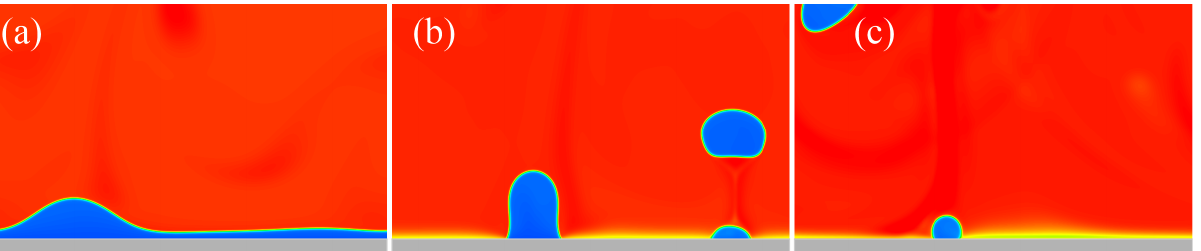
Figure 3. The density contour plots illustrating the boiling process at low surface superheat, Δ T = 0.045 T c . ( a ) lyophobic surface ( θ = 116°), ( b ) neutral surface ( θ = 90°) ( c ) lyophilic surface ( θ = 38°).